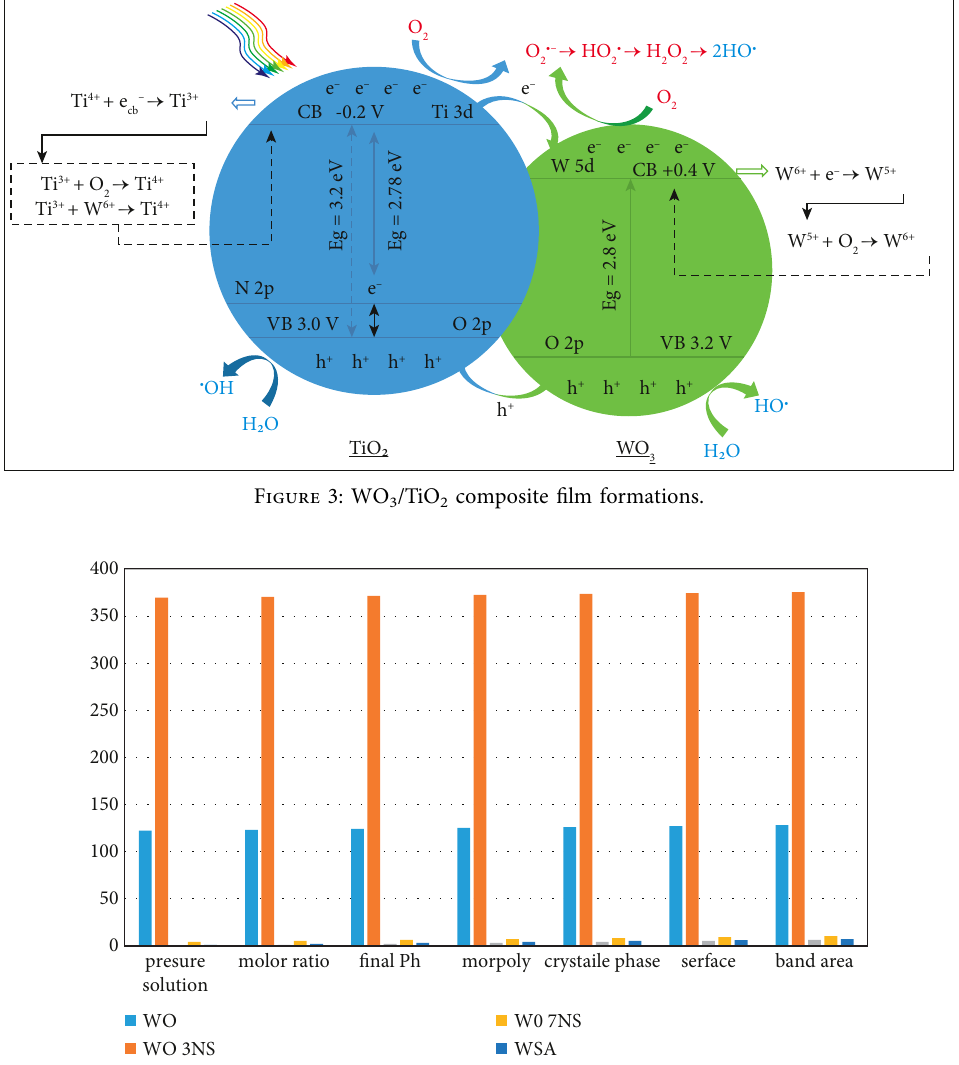
3 photocatalysts. Included are the characteristics of